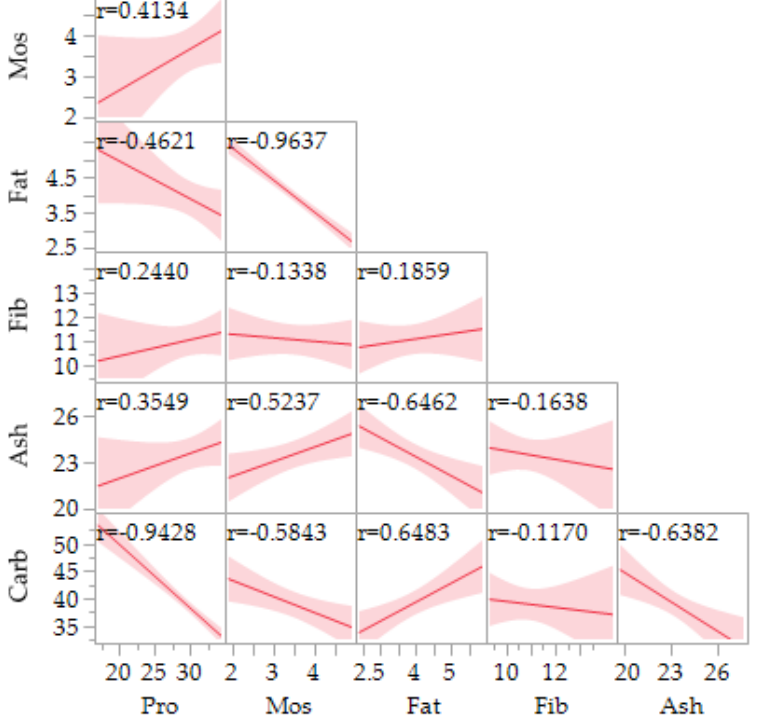
Figure 5. Correlation matrix for moisture (Mos), protein (Pro), fat, fiber (Fib), ash, and carbohy- drate(Carb) for high tunnel-grown quinoa leafy greens in 2020, and 2021.